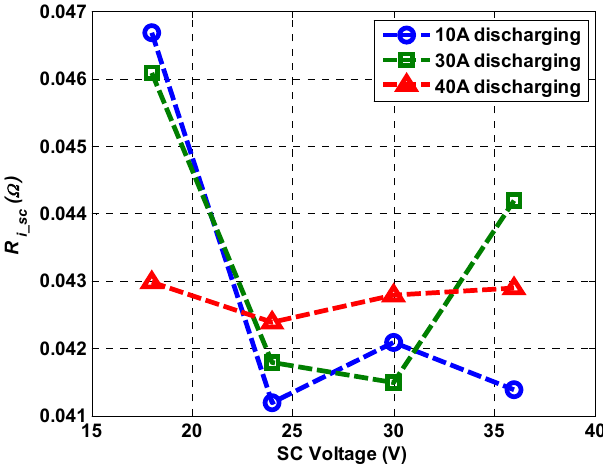
Figure 13. Series resistances of the supercapacitor with respect to the voltage and current.